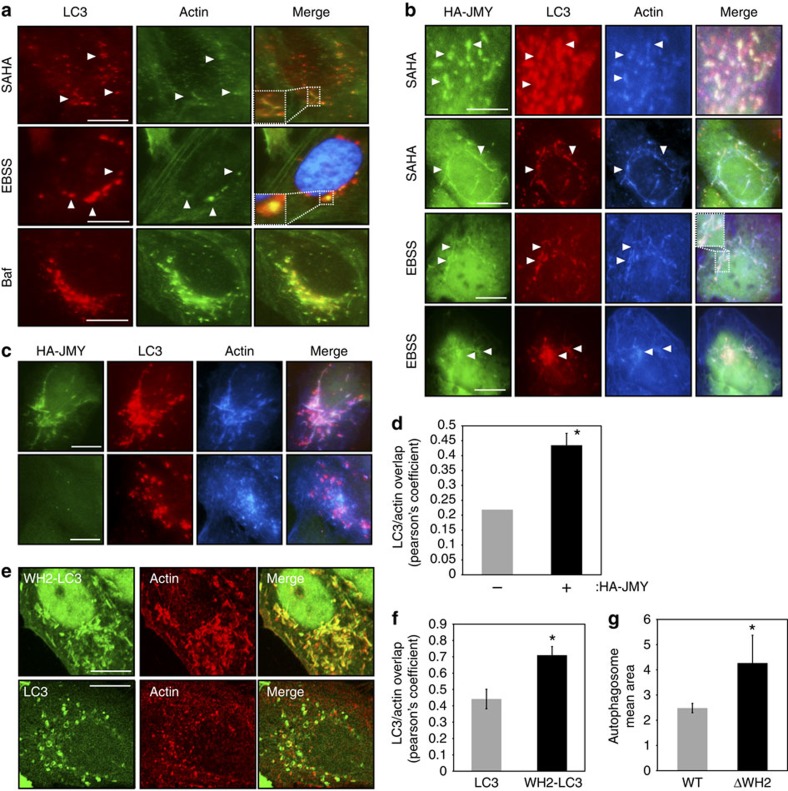
Actin is involved in autophagosome formation.(a) U2OS cells treated with SAHA, bafilomycin A1 (Baf) or starved with EBSS, all for 4 h. Rabbit anti-LC3 and mouse-actin antibodies were used. Insets show enlarged regions. Scale bar, 10 μm. (b,c) U2OS cells expressing JMY and derivatives were treated for 6 h with SAHA or EBSS as denoted. JMY was detected with goat anti-JMY antibody L16, actin with mouse anti-actin and LC3 with rabbit anti-LC3. Scale bar, 10 μm. (d). Quantitative data of cells treated as in c. Data are represented as the Pearson's coefficient of the LC3 and actin signal correlation in the presence or absence of JMY. n=>20 cells per treatment, two independent experiments. *P<0.0001, Student's t-test. (e) U2OS cells expressing mcherry–GFP–LC3 (LC3) or mcherry–GFP–WH2–LC3 (WH2–LC3) were treated with SAHA (6 h). Actin was visualized with mouse anti-actin antibody and false coloured red for visualization purposes. Scale bar, 10 μm. (f) Quantitative data of cells treated in e. Data are represented as the Pearson's coefficient of the LC3 and actin signal correlation. n=>20 cells per treatment, two independent experiments. *P<0.001, Student's t-test. (g) The mean area of the autophagosomes quantified in 6 h SAHA treated HA-JMY and HA-JMYΔWH2 expressing U2OS cells using an IN Cell Analyser 1000, n=>150 cells per treatment, two independent experiments. *P<0.1, Student's t-test. Error bars in all graphs are mean±s.e.m.